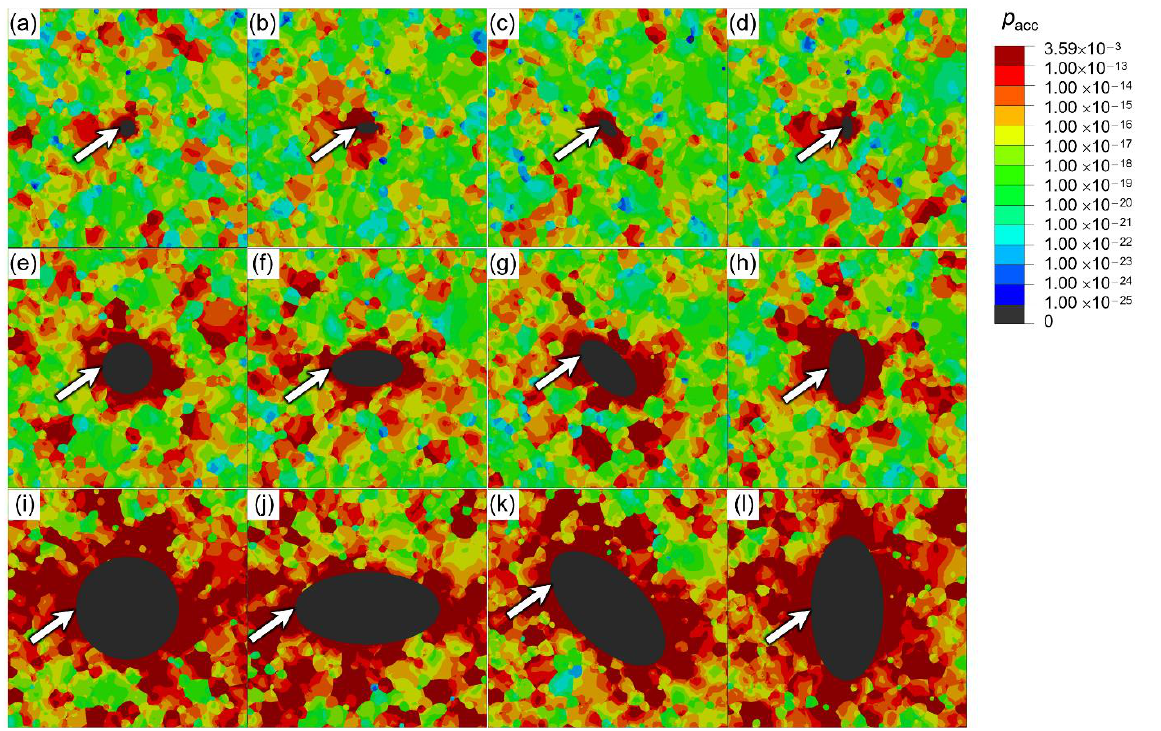
Figure 6. The p acc contour distributions of steel matrix in on typical RVEs after six-cycle simulation of tension – compression fatigue stress (white arrows pointing at the position of P max ): ( a – d ) √𝑎𝑟𝑒𝑎 = 26.6 μm; ( e – h ) √𝑎𝑟𝑒𝑎 = 13.3 μm; ( i – l ) √𝑎𝑟𝑒𝑎 = 4.2 μm .